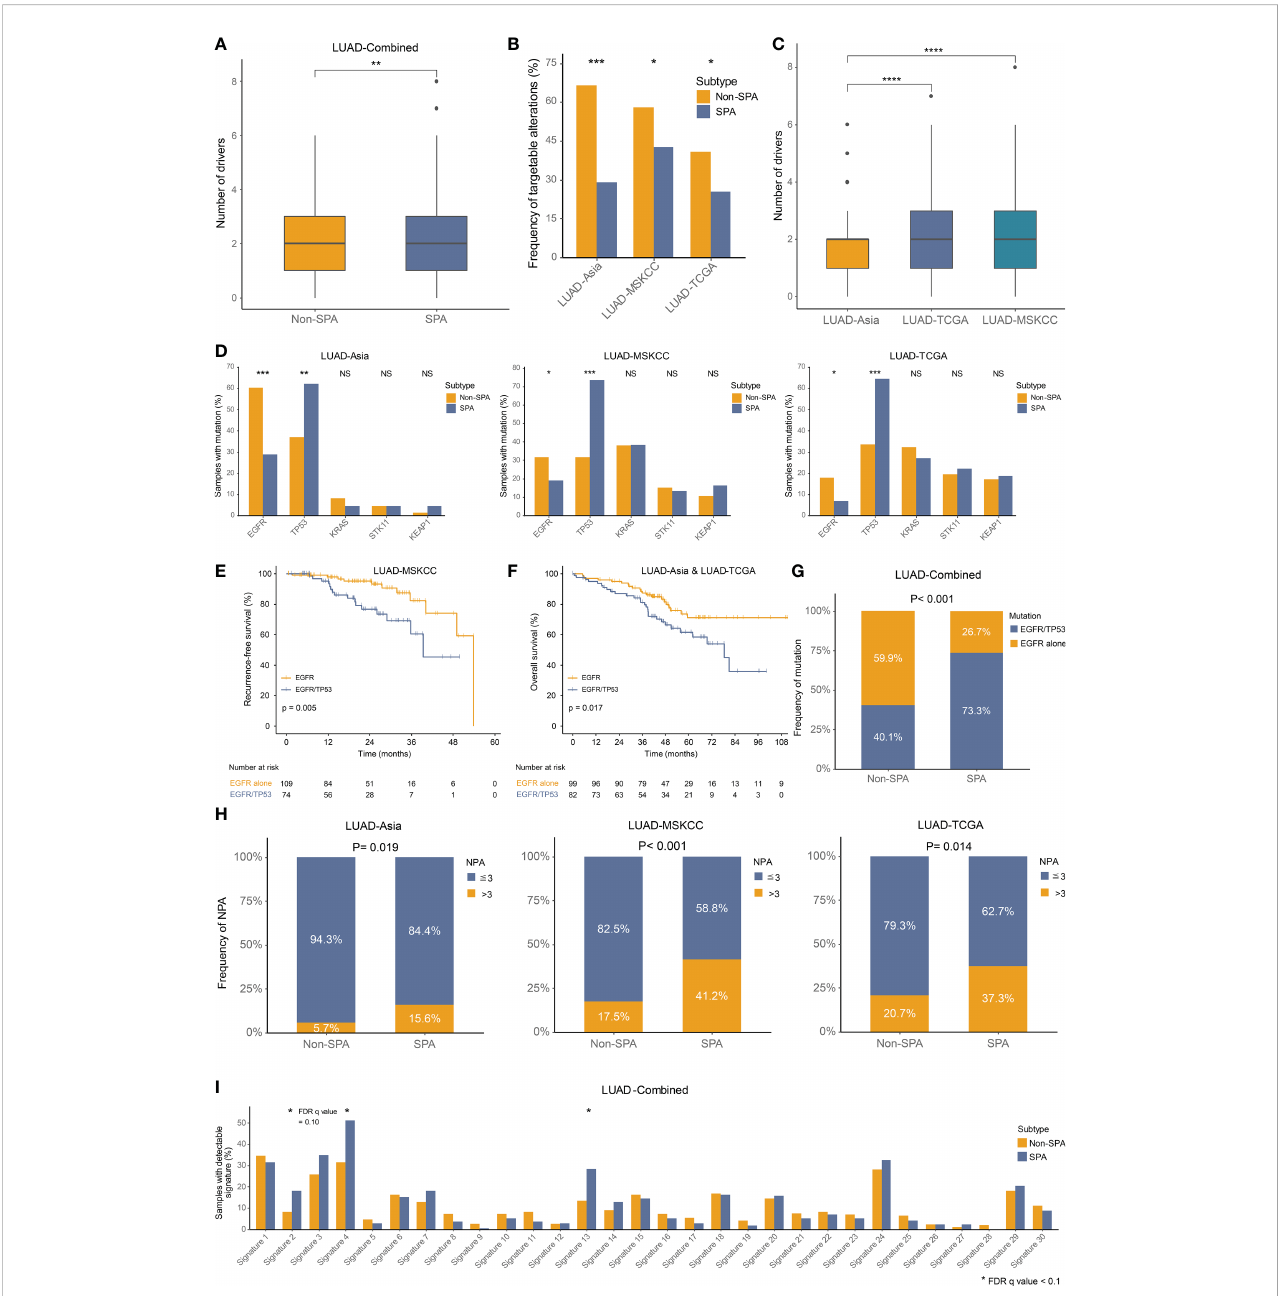
FIGURE 4 Driver mutations, oncogenic pathways and somatic mutational signatures in SPA and Non-SPA (A) Number of driver mutations in SPA and Non-SPA. **P < 0.01 (B) Frequency of targetable alterations in SPA and Non-SPA across the three cohorts. ***P < 0.001, *P < 0.05 (C) Differences in number of driver mutations between races. ****P < 0.0001 (D) Mutation frequency of EGFR, TP53, KRAS, STK11, and KEAP1 in SPA and Non-SPA across the three cohorts. ***P < 0.001, **P < 0.01, *P < 0.05; NS, not signi fi cant (E) Recurrence-free survival of EGFR mutation alone versus EGFR/TP53 co-mutation. (F) Overall survival of EGFR mutation versus EGFR/TP53 co-mutation. (G) Frequency of EGFR mutation alone and EGFR/TP53 co-mutation in SPA and Non-SPA. (H) Frequency of three or more pathways altered in SPA and Non-SPA across the three cohorts. (I) Frequency of 30 COSMIC signatures in SPA and Non- SPA. *FDR q value < 0.1. SPA, solid predominant adenocarcinoma; Non-SPA, non-solid predominant adenocarcinoma; NPA, number of pathways